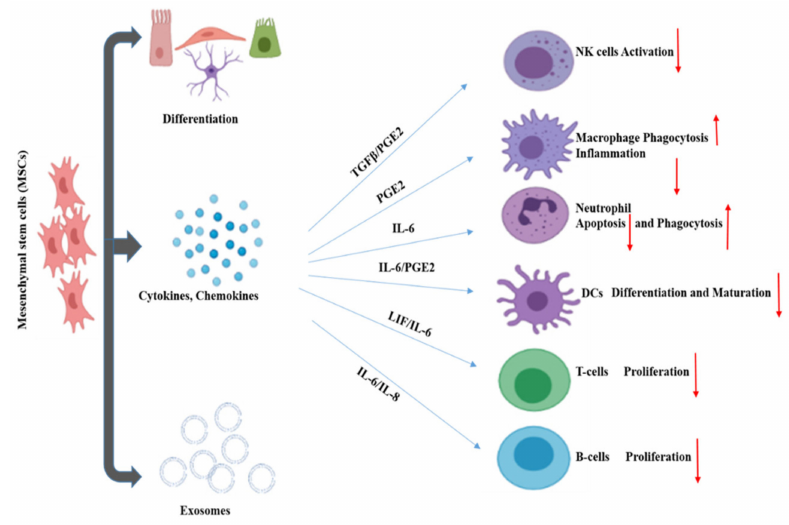
Figure 2. Immunomodulatory effects of mesenchymal stem